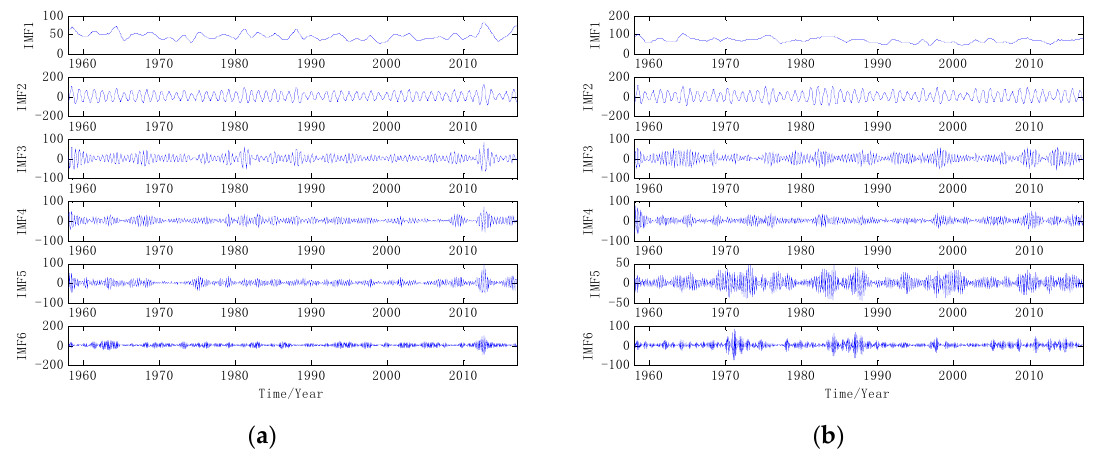
Figure 4. The results of VMD method ( a ) Yan’an; ( b ) Huashan.